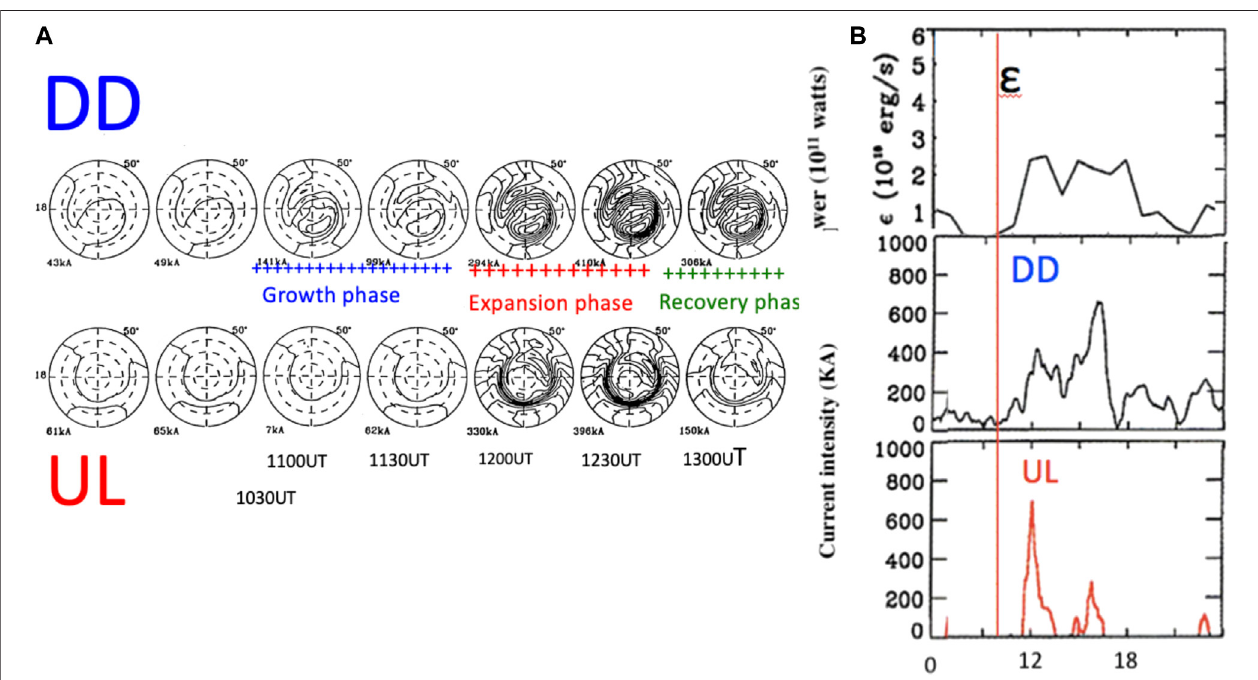
FIGURE13|(A) ThedevelopmentofthecurrentpatternforboththeDDandtheULcurrentsduringthegrowth,expansionandrecoveryphases. (B) Thevariations of the DD and UL currents with the power.